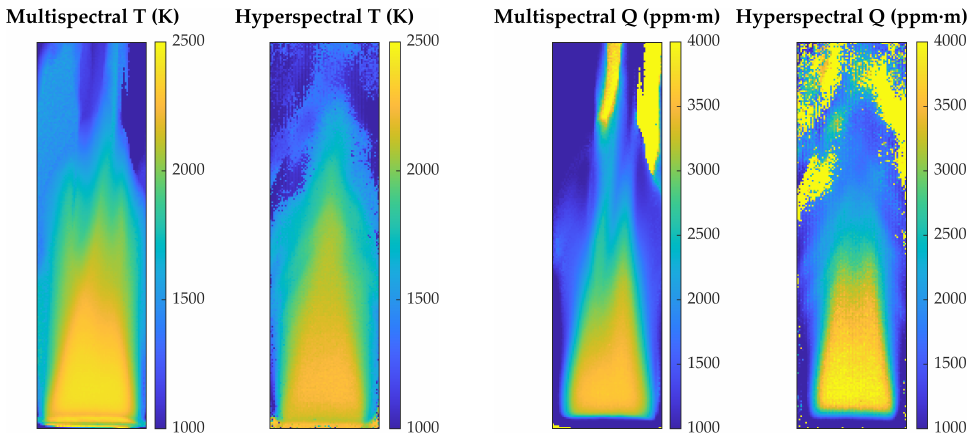
Figure 6. Maps of temperature and CO 2 column density for the stoichiometric ( φ = 1) standard flame, obtained with the multispectral method and with the hyperspectral method.